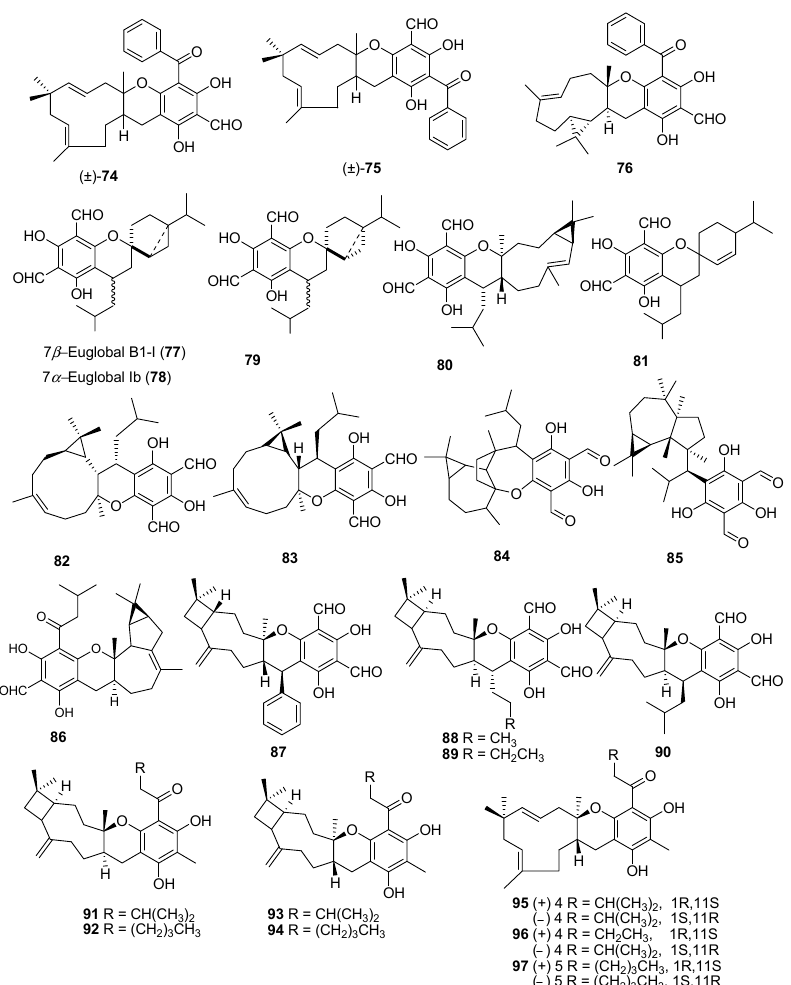
Figure 7. Meroterpenoids isolated from P. guajava L.